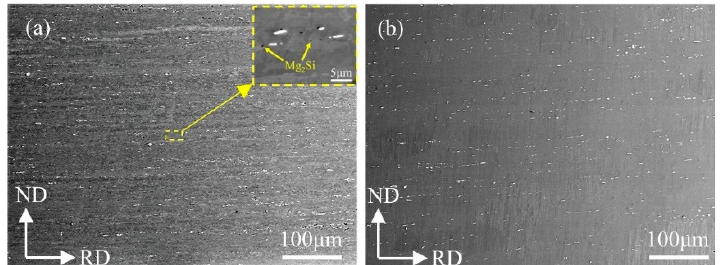
Figure 10. Precipitation morphology and distribution of hot-rolled 6063 aluminum alloy. ( a ) VCR; ( b ) VHR.